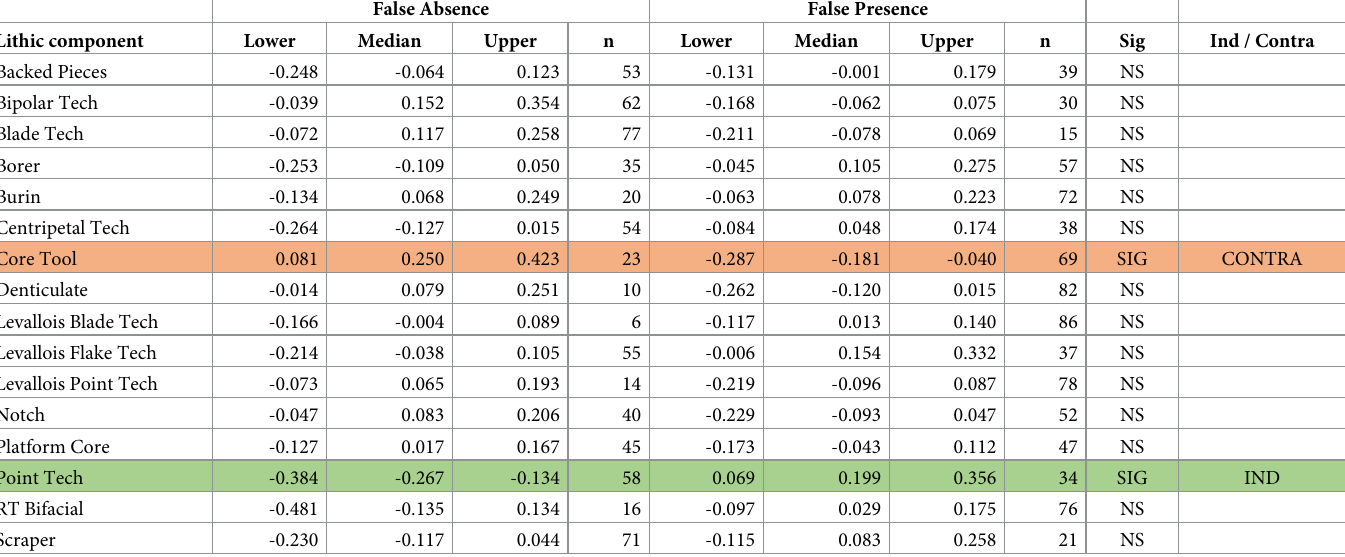
Table 5. Significant indicators of MIS3&4 MSA assemblages in the 3-way analysis. Details as per Table